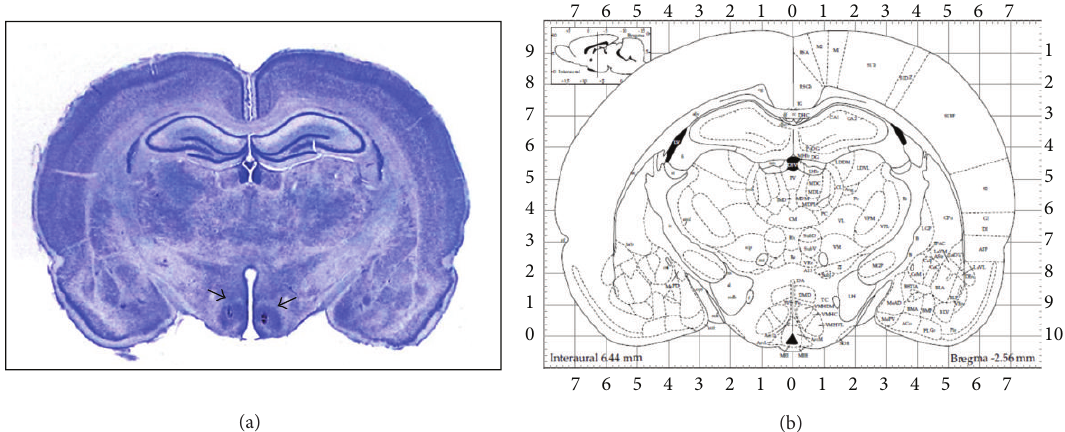
Figure 1: Sites of electrode implantation for cerebral electrical stimulation in rats. (a) Photograph of electrodes implanted in the ventrolateral portion of hypothalamic ventromedial nuclei, VMHvl (bregma − 2.6 mm)in a coronal section of brain rat, stained with the Nissl Technique (5x). (b) Schematic representation of the VMHvl